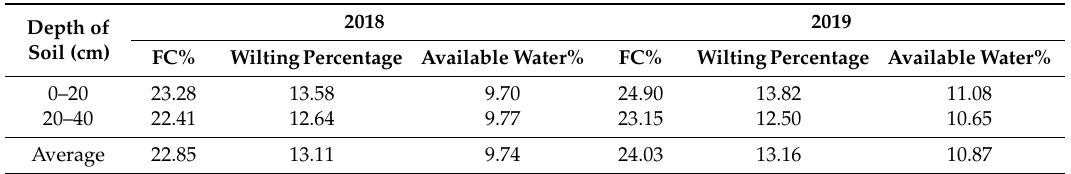
Table 2. Field capacity, wilting point and available soil water of the experimental soil in the two seasons of 2018 and